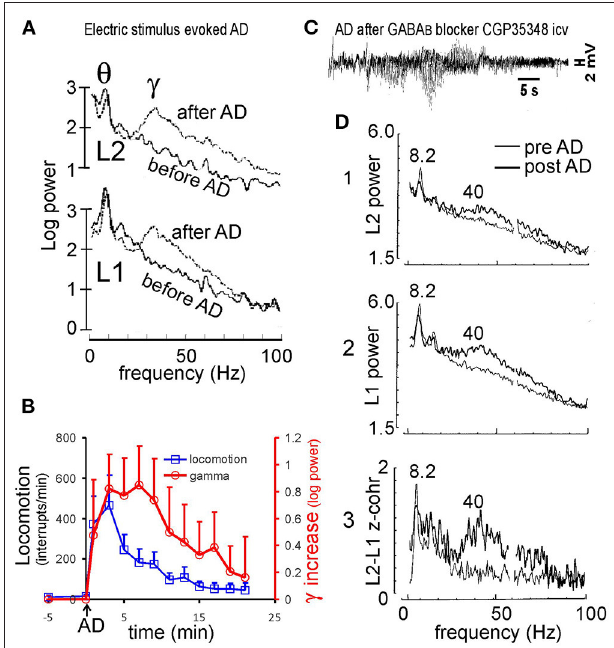
FIGURE 2 | Hippocampal seizure and gamma. (A) Electrically induced after discharge (AD) in the hippocampus induced large gamma activity at electrodes across hippocampal CA1 area; L1 electrode placed at stratum radiatum, and L2 at near the alveus. (B) Minute by minute horizontal locomotion (infrared beans interrupts/min) and increase in hippocampal gamma (30–60Hz) from baseline after a hippocampal AD at time 0; mean plus SE ( n = 4 rats). (C) Characteristic pattern of hippocampal AD was observed at 17min after injection of GABA B receptor antagonist CGP35348 (110 µ g intraventricular, icv). (D) Power spectra at L1 and L2 electrodes across CA1, and L1-L2 coherence z-transform spectrum, recorded at 13min after the CGP35348-induced AD (dark traces), overlaid with those during baseline walking (light traces). Power and coherence were high at theta (8.2Hz) and gamma (peak at ∼ 40Hz). Power at the theta peak corresponded to ∼ 1mV of theta amplitude at L1 electrode. (A) After Leung (1987), (C,D) after Leung et al.